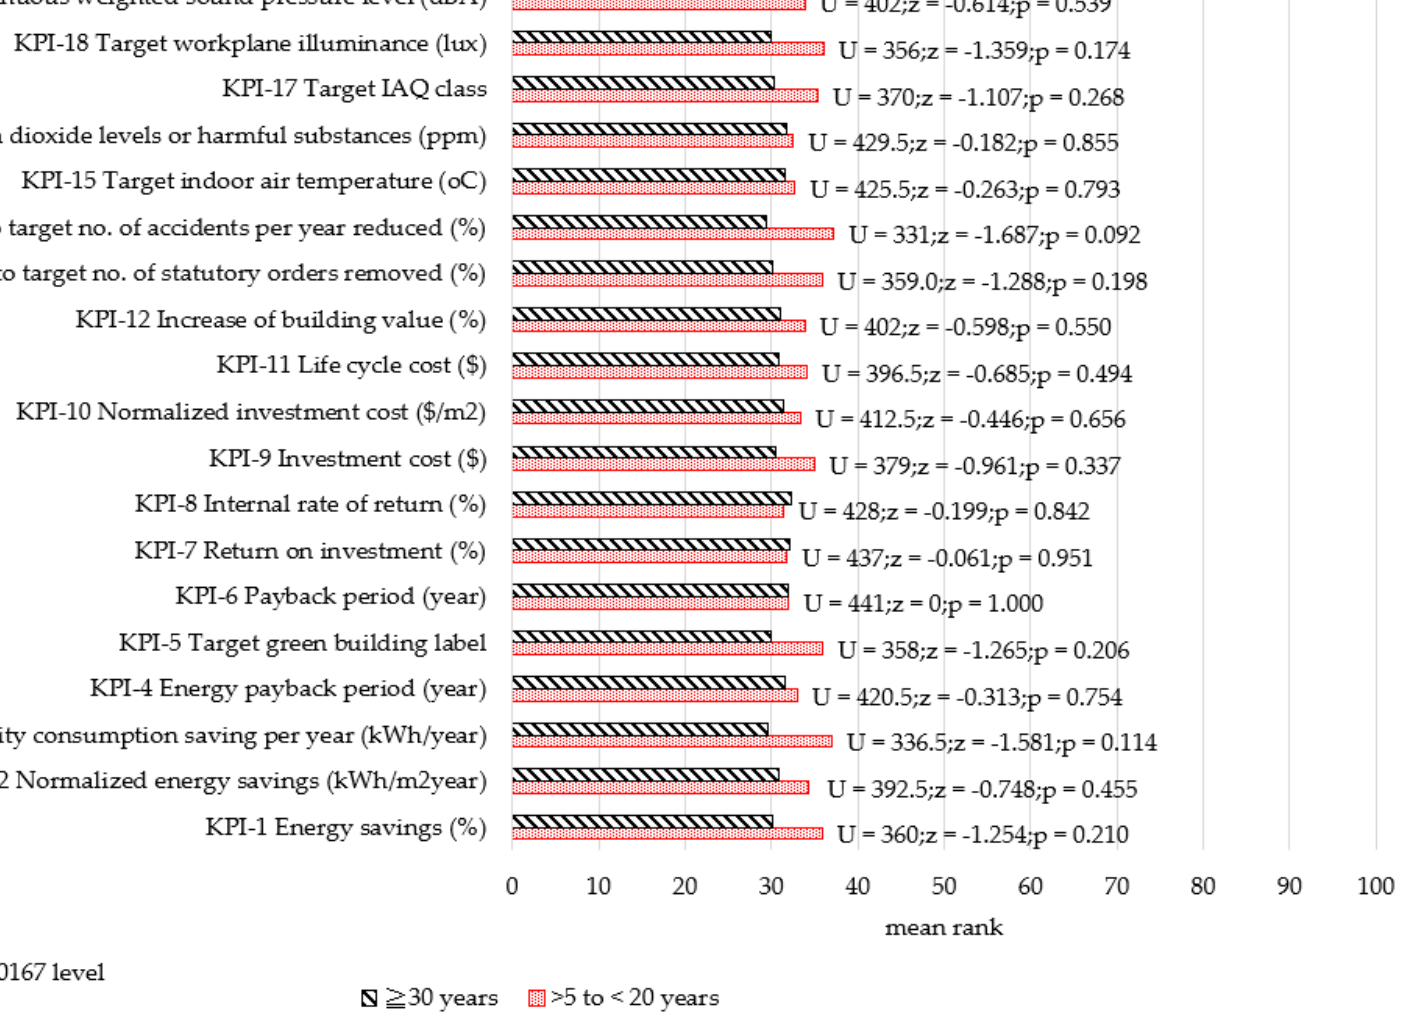
Figure A9. Mann – Whitney U-test results of G2 (work experience: G2b vs. G2d). Figure A9. Mann–Whitney U-test results of G2 (work experience: G2b vs.